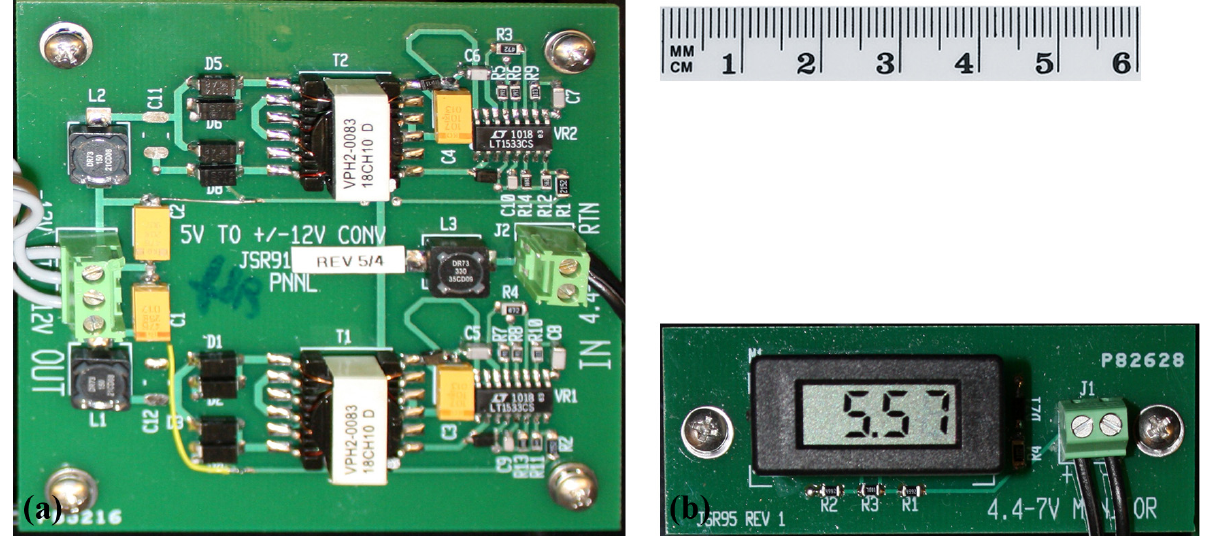
Figure 2. Power conversion unit. ( a ) Power converter board; ( b ) battery voltage